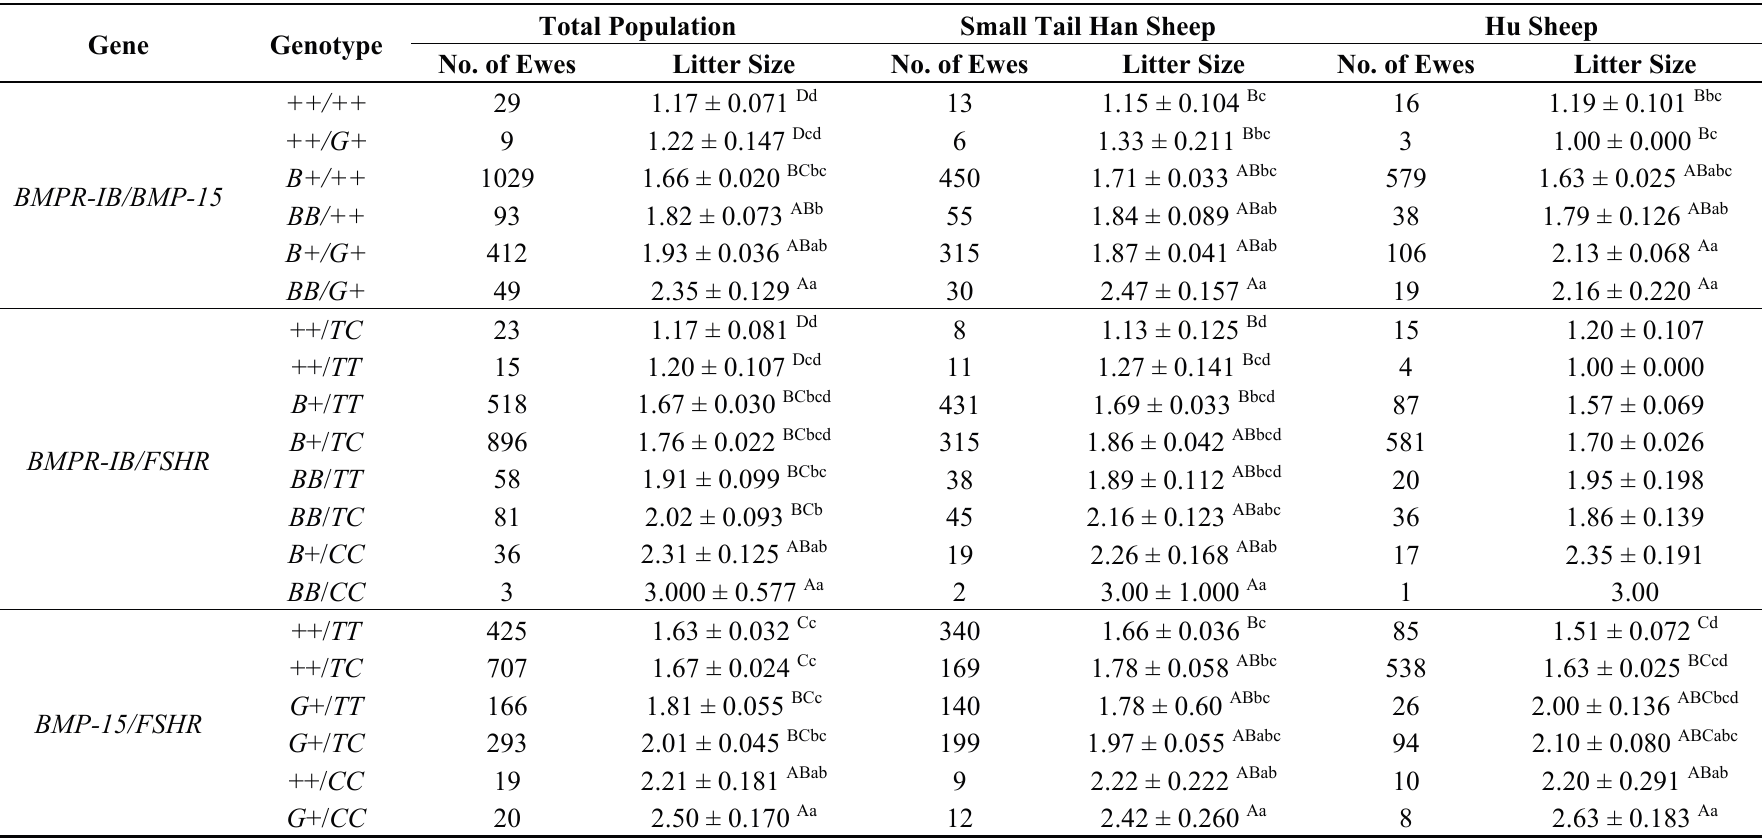
Table 3. Combined effect analysis of two genes ( BMPR-IB/BMP-15 , BMPR-IB/FSHR and BMP-15 / FSHR ) on litter